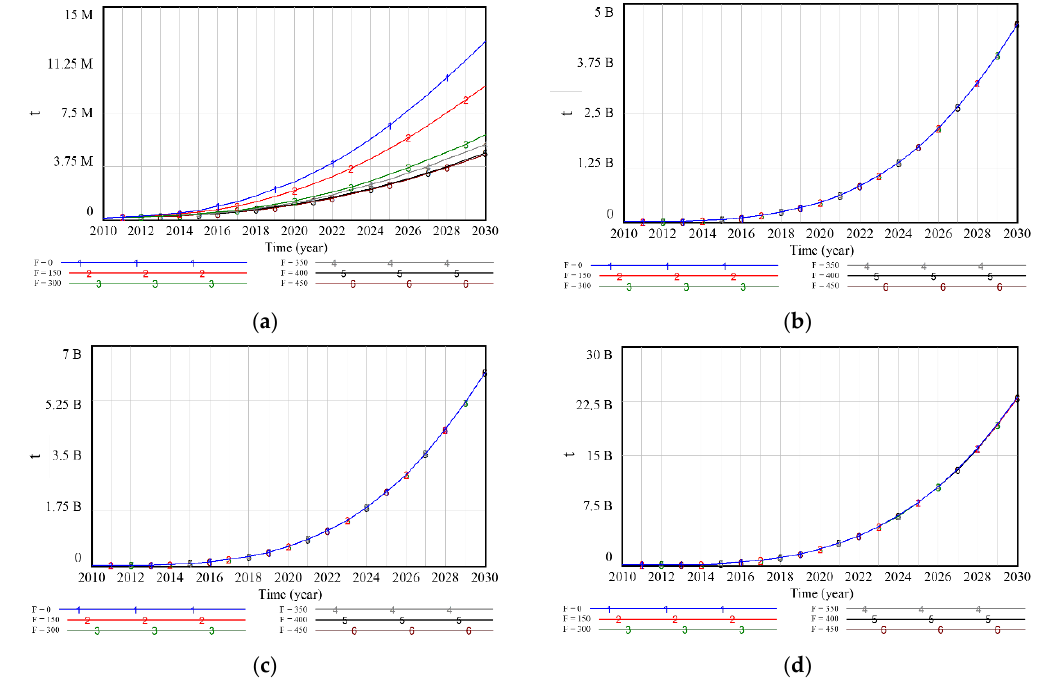
Figure 6. Effect of fine policy on key variables. ( a ) Total illegal dumping. ( b ) Total recycling. ( c ) Total landfill. ( d ) Environmental benefit. Table 2. Changes in the total amount of illegal dumping corresponding to different